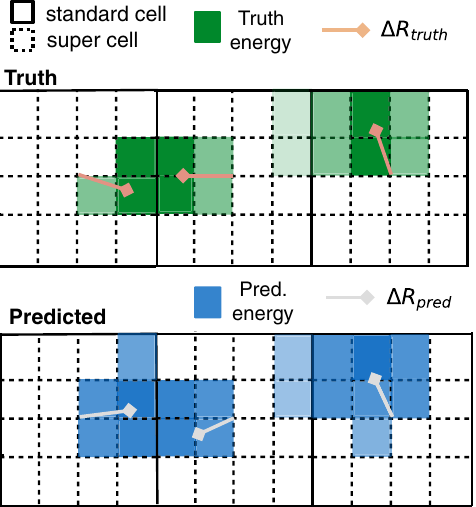
barycenter of the neutral energy distribution of the super cells and the center of the corresponding standard cell is outlined in blue. (right) Rel- ative residuals distributions of the radial distance for the different NN architectures